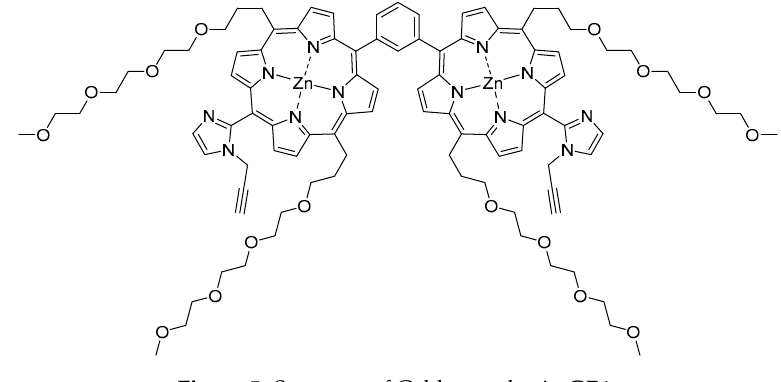
Figure 5. Structure of Gable porphyrin GP1 .